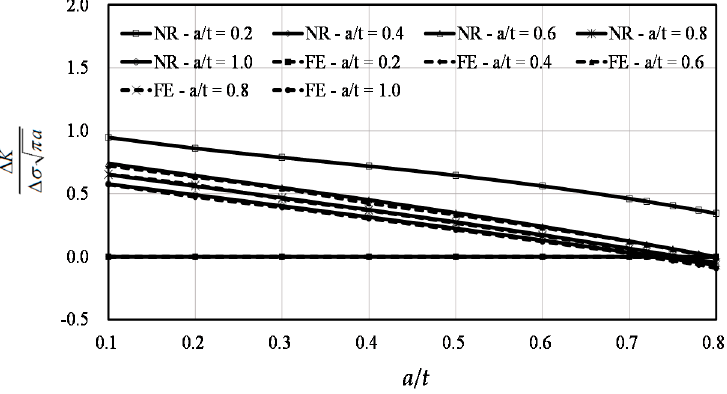
Figure 11. The finite element results vs. the Raju-Newman solution at point A .